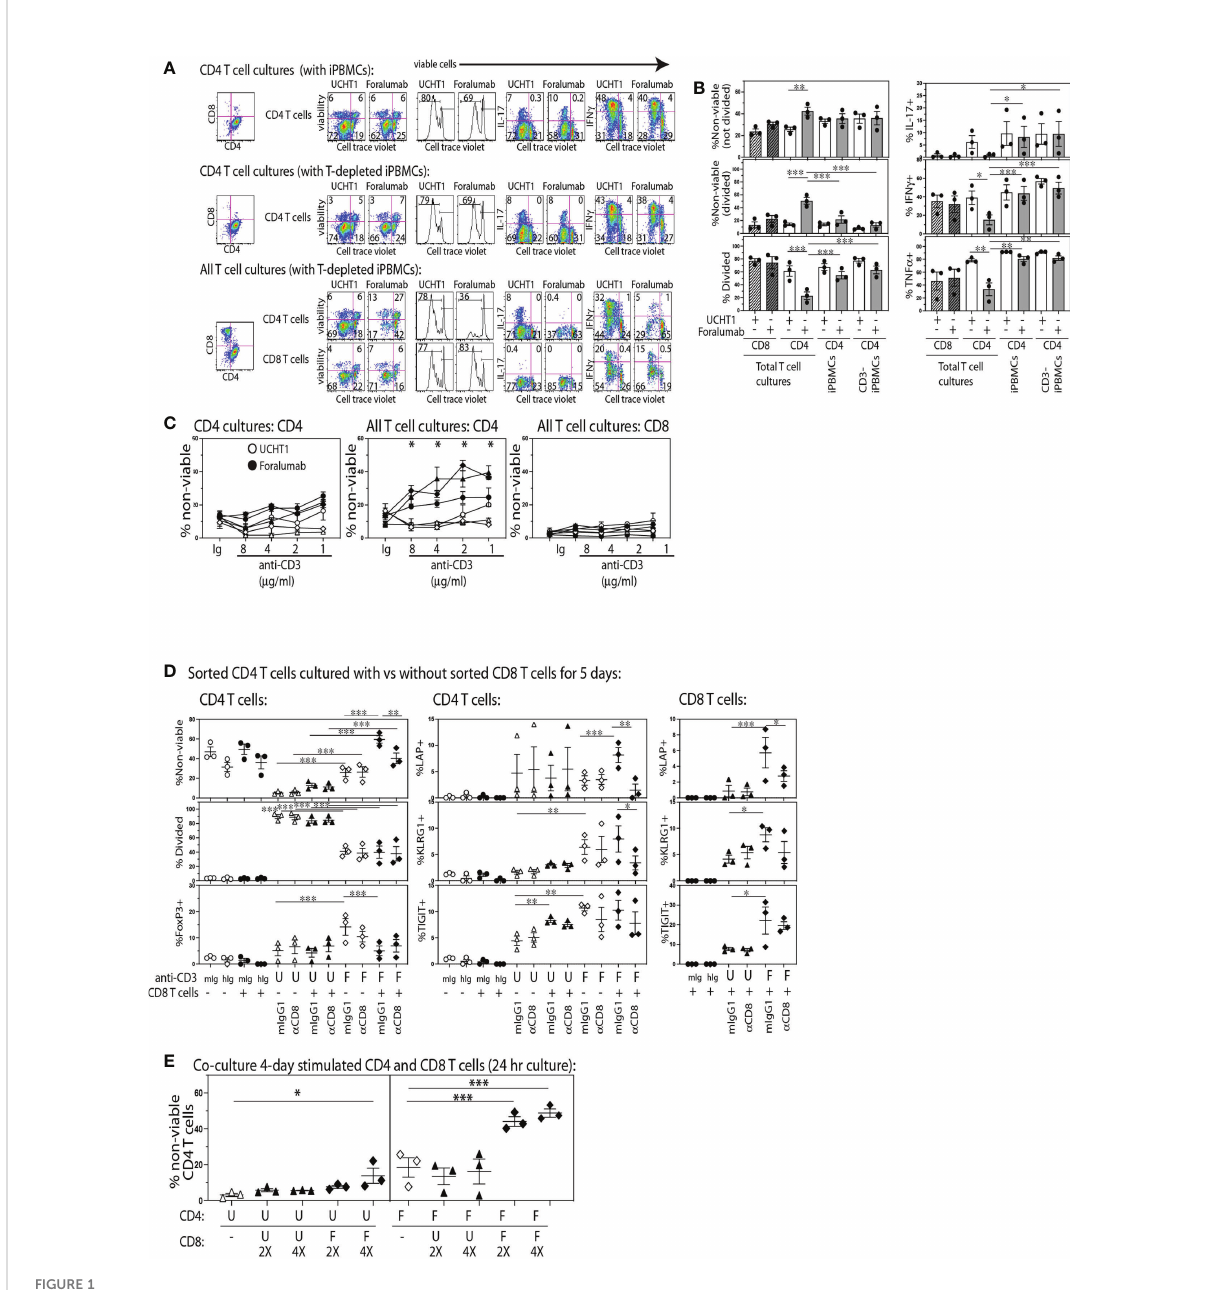
FIGURE 1 The Foralumab anti-CD3 mAb exhibits unique in vitro stimulation properties via its capacity to induce regulatory function in CD8 T cells. (A) Representative FACs plots are shown for the changes in viability, proliferation and cytokine expression by cell trace labeled CD4 T cells when stimulated with UCHT1/IL2 or Foralumab/IL2 when puri fi ed or in the presence of non-CD4 T cells, and irradiated PBMCs (with and without T cell depletion) as APCs. (B) Graphical analysis of changes in features within the cell trace diluted CD4 T cells (from three healthy donors) in response to the different culture conditions. (C) Changes in viability was examined in a dose response of 5,000 T cells stimulated with Foralumab/IL2 ( fi lled) vs UCHT1/IL-2 (open) as compared to mIgG1/IL-2 or huIgG1/IL-2. Viability was determined at 5 days by e506 staining. (D) FACS-sorted total CD4 T cells were stimulated alone (open) or together with autologous FACS-sorted CD8 T cells ( fi lled) with mIgG1 (isotype for UCHT1), huIgG1 (isotype for Foralumab), UCHT1 or Foralumab. All in the presence of IL-2 (5U/ml), and T cell depleted irradiated PBMCS as APCs. On day 5, the cultures were harvested and measured for viability, proliferation, and surface expression of LAP, KLRG1 and TIGIT, and intracellular FoxP3. (E) CD8 T cells that were stimulated with Foralumab for 4 days were tested for the capacity to kill activated UCHT1 or Foralumab stimulated CD4 T cells. On day 4, the different anti-CD3 stimulated CD4 and CD8 T cells were harvested, washed and re-plated in all combinations in the presence of IL-2 (5U/ml) at the indicated ratios (5,000 CD4 and 2X or 4X activated CD8 T cells). The information for the isotypes re fl ected features expressed by cell trace high populations as there was no proliferation. For all graphs, signi fi cance was determined by One-Way ANOVA with Sidak ’ s correction for multiple comparisons, * p<0.05, **p<0.01,